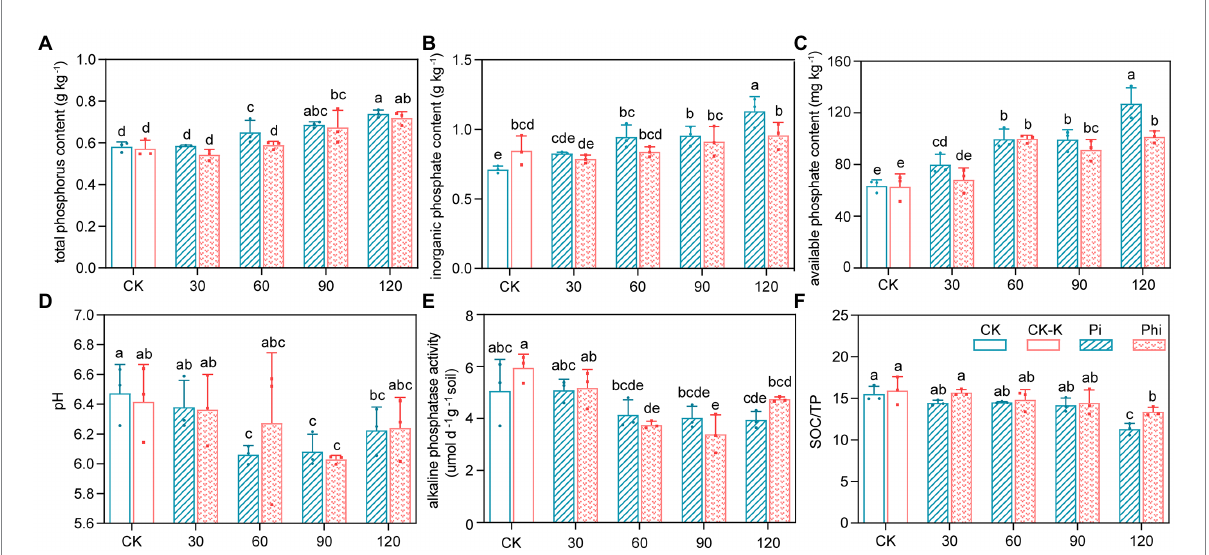
FIGURE 1 Soil properties of the phosphate- and phosphite-fertilized fields. (A) Total phosphorus content. (B) Inorganic phosphorus content. (C) Available phosphorus content. (D) pH value. (E) Alkaline phosphatase activity. (F) Soil organic carbon to total phosphorus ratio. The treatment levels are presented as the average value ± standard error ( n = 3). Different lowercase letters indicate significant differences ( p < 0.05). CK, non-fertilized control; CK-K, potassium-fertilized control; Phi, phosphite fertilizer treatment; Pi, phosphate-fertilized treatment. The values 30, 60, 90, and 120 represent the treatment